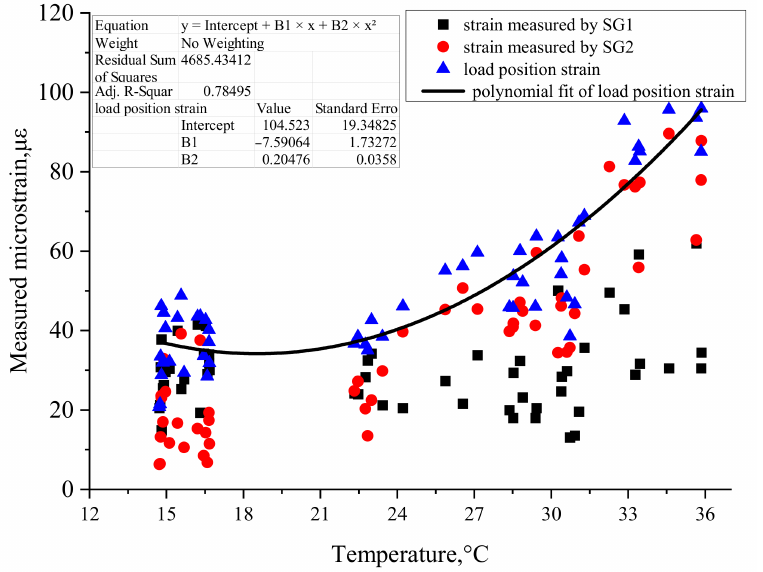
Figure 9. Load position strain calculated from proposed method with different temperatures from April to